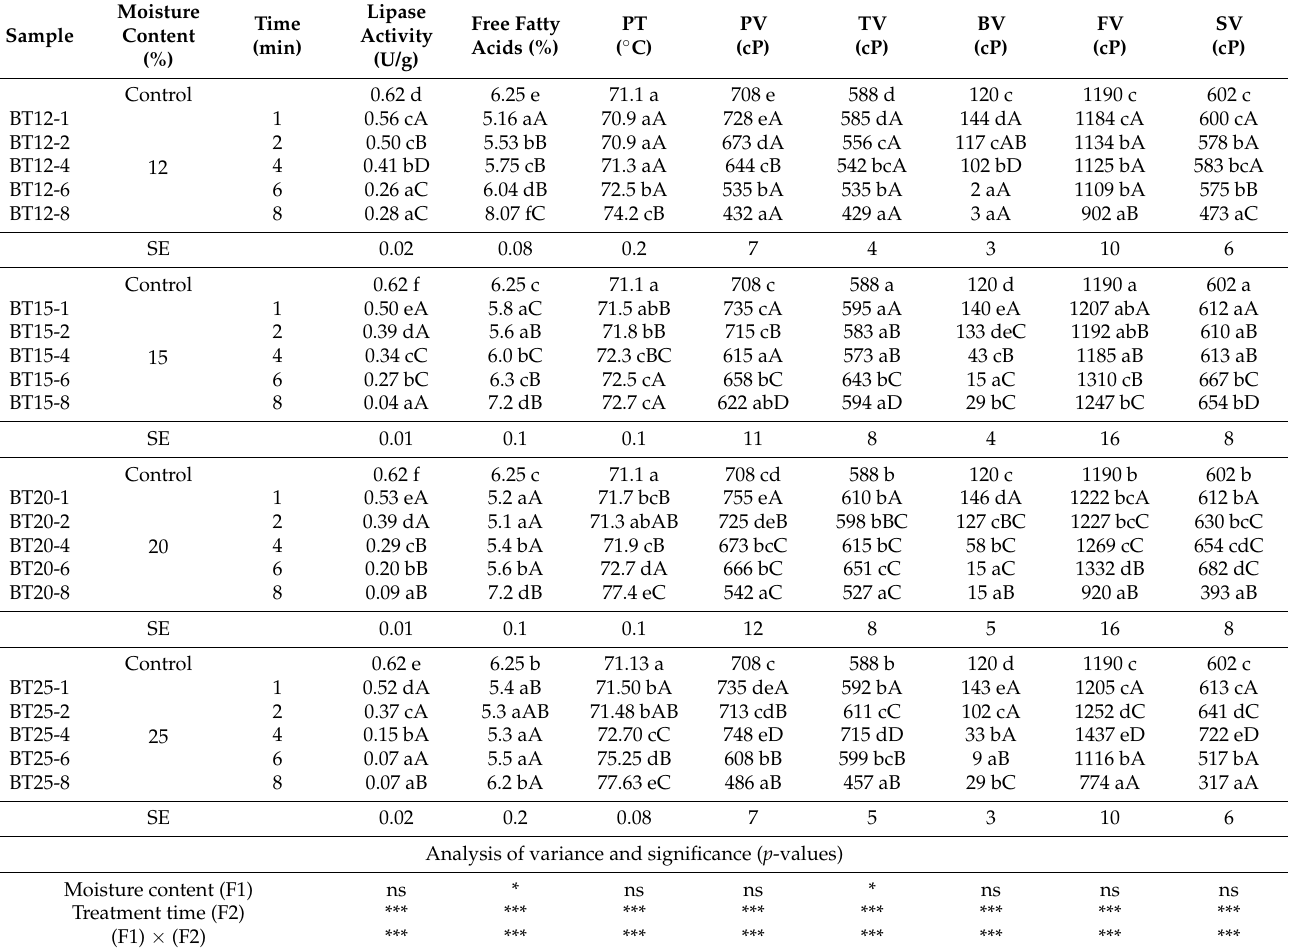
Table 2. Lipase activity, free fatty acids, and pasting properties of samples